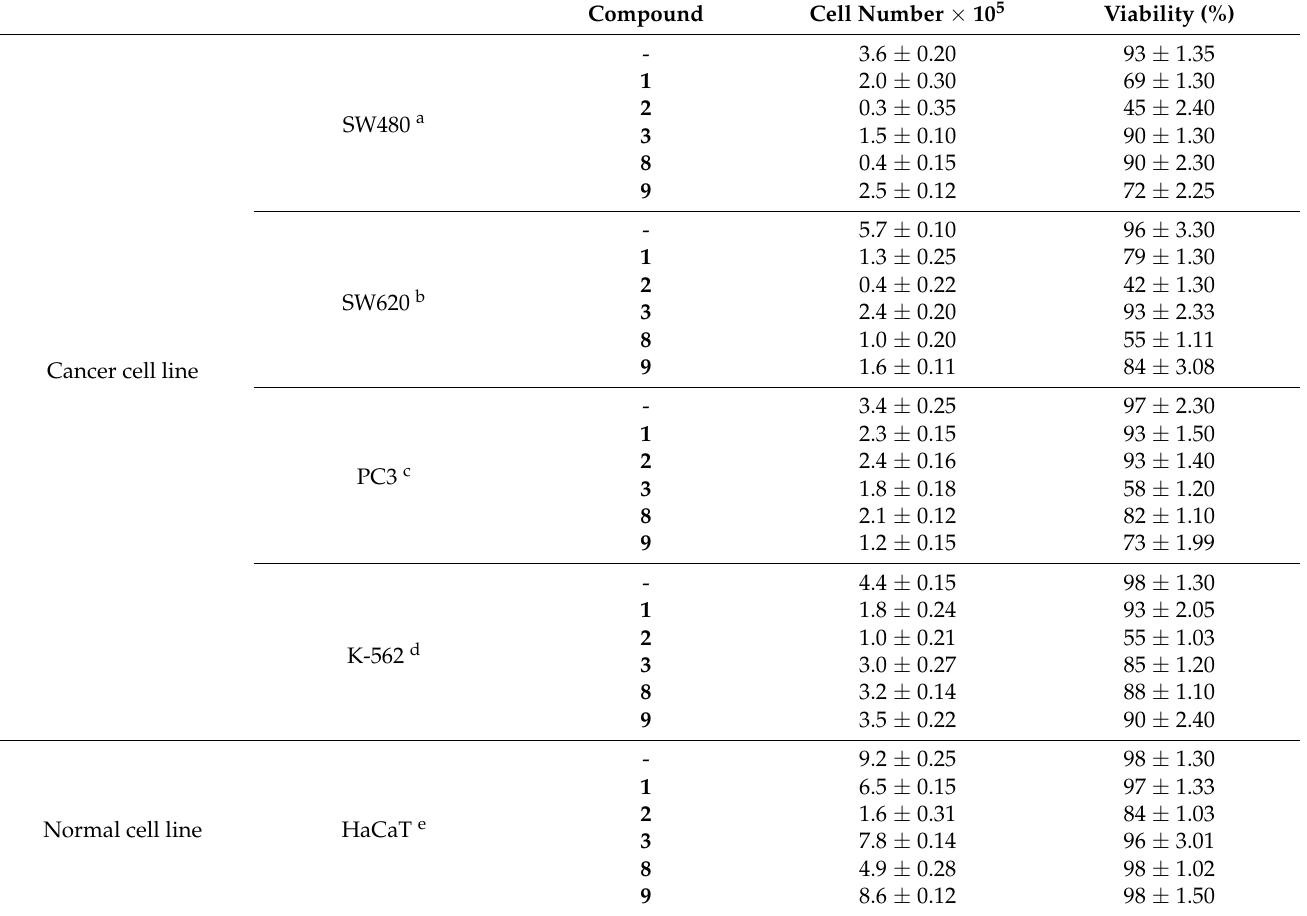
Table 2. Trypan blue assay. The effect of compounds 1 , 2 , 3 , 8 , and 9 on the live cell number and viability (%) in SW480, SW620, PC3, K-562, and HaCaT cells. Cells were incubated for 72 h with the tested compounds used in their IC 50 concentrations, then cells were harvested, stained with trypan blue, and analyzed using a cell counter. Data are expressed as the mean ± SD.- “control without compound”, a Human primary colon cancer (SW480), b Human metastatic colon cancer (SW620), c Human metastatic prostate